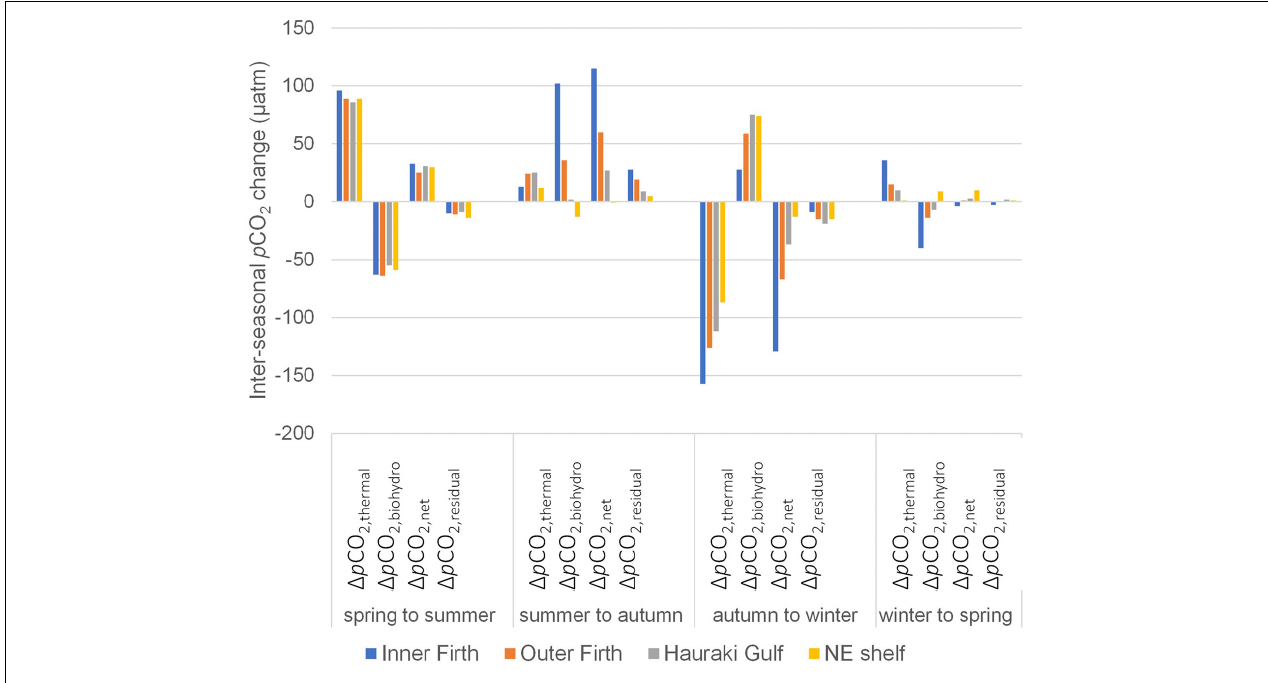
FIGURE 10 | Effects of inter-seasonal changes of surface layer temperature and combined metabolism/mixing processes, on changes of surface layer p CO 2 ( µ atm), for inner Firth, outer Firth, Hauraki Gulf and the NE shelf regions. Net change of p CO 2 ( (cid:49) p CO 2 , net ) is the sum of temperature ( (cid:49) p CO 2 , thermal ) and metabolic/mixing effects ( (cid:49) p CO 2 , biohydro ). Residual change of p CO 2 ( (cid:49) p CO 2 , residual ) is net change minus change in observed p CO 2 ( (cid:49) p CO 2 , observed ) ( Table 2 ). TABLE 3 | Seasonal and annual averages of (A) Firth GPP, (B) ratios of C fixed within the Firth water column by GPP to total organic C loaded by rivers to the Firth. Spring Summer Autumn Winter